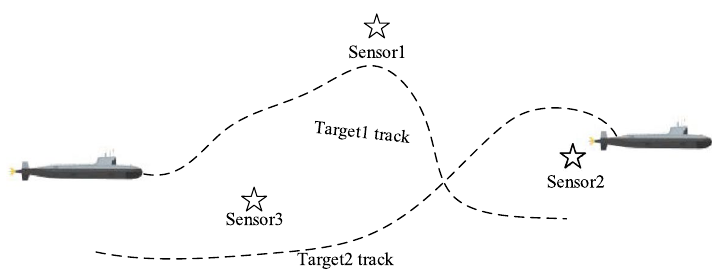
Fig. 1 Multi-target motion model